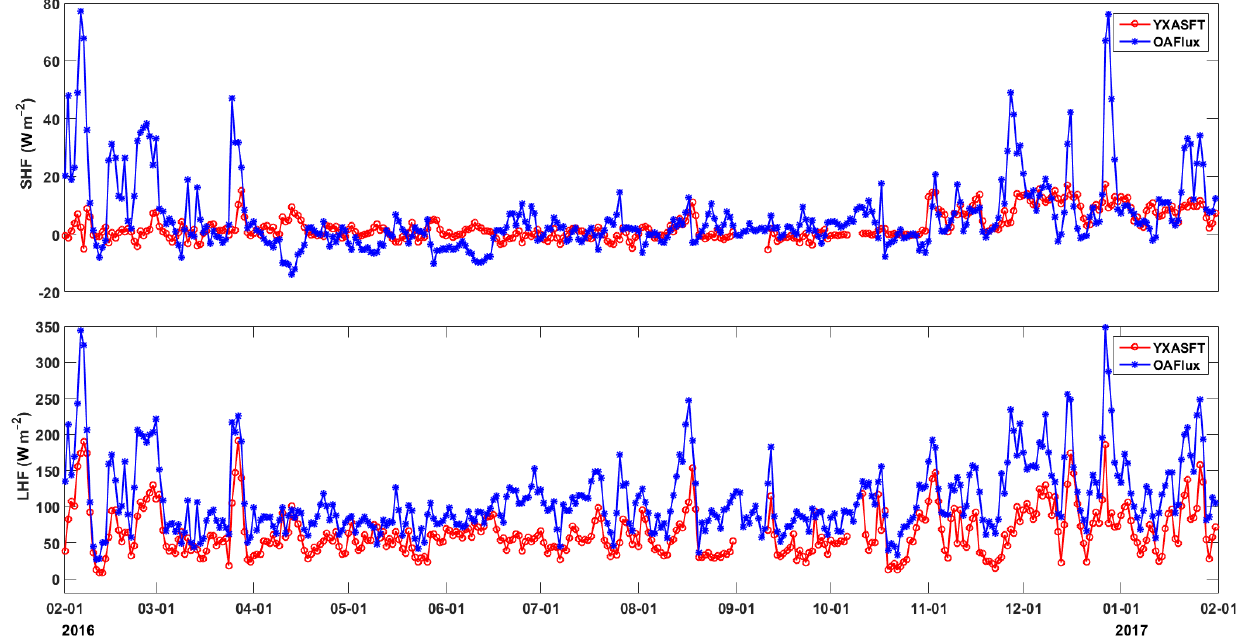
Figure 6. Daily mean time-series plots of the YXASFT-observed (red solid lines) and OAFlux-analyzed (blue solid lines) SHF and LHF